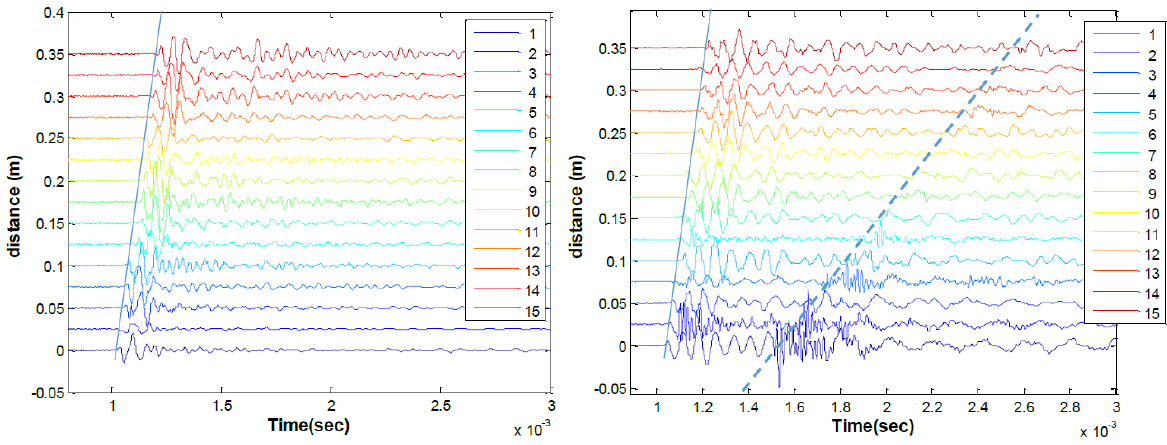
Figure 17. Seismic MASW time signals from sensor array collected from 200 mm thick concrete slab; data from contact accelerometers ( left ) and MEMS ( right ). Blue solid lines indicate expected surface wave arrival and dashed line indicates expected acoustic wave arrival.